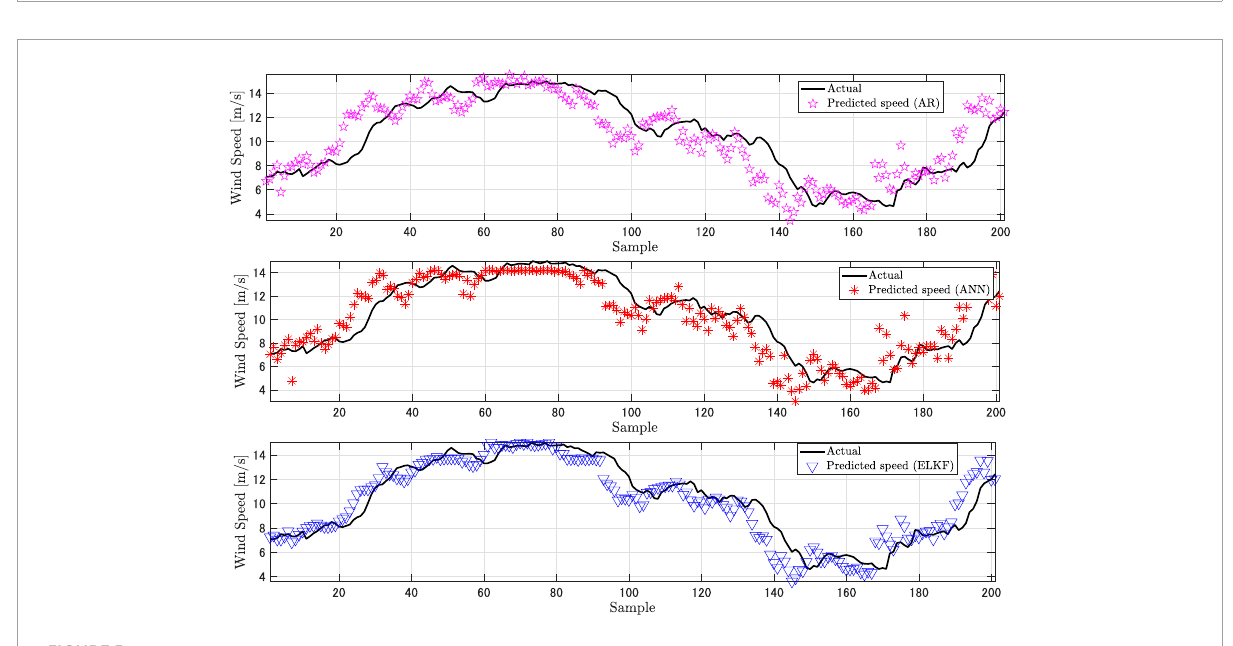
method show smaller deviations and strong correlations between the actual values and